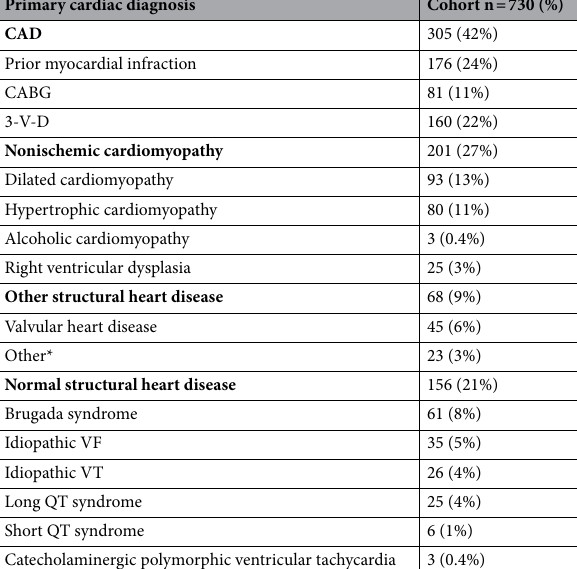
Table 1. Primary cardiac diagnosis of patients with sudden cardiac death. CAD coronary artery disease; CABG coronary artery bypass grafting; 3-V-D three vessel disease; VF ventricular fibrillation; VT ventricular tachycardia. *Other: TGA (Transposition of the great arteries), TOF (Tetralogy of Fallot), Amyloidosis, LV